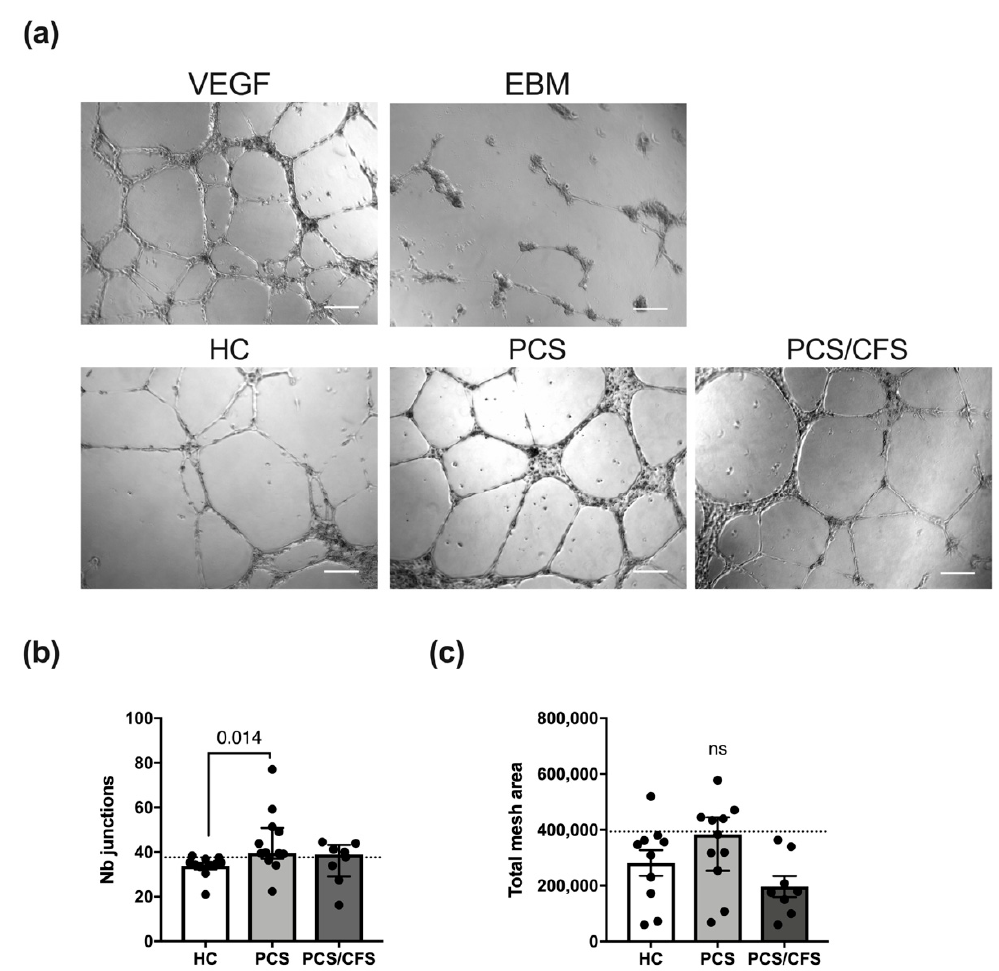
Figure 4. In vitro angiogenesis assay for serum-treated cultured human endothelial cells. ( a ) Representative micrographs of HUVEC treated with serum of healthy controls (HC) and both patient groups (PCS, PCS/CFS) as well as the two control settings are shown. Scale bars represent 200 µm. Experiments were performed in duplicate wells and micrographs of five areas from each well were taken. Measurements were taken with the Angiogenesis Analyzer plugin of ImageJ 1.50i. Bar graphs display the network analysis parameters ( b ) number of junctions and ( c ) total mesh area, across the patient and control groups. Shown are median, interquartile range and individual values Dotted lines denote the 90th percentile of the HC group. Statistical significance was determined using a Kruska-Wallis test. A p value ≤ 0.05 was considered significant. HC, healthy controls (n = 10). PCS, post-COVID-19 syndrome (n = 11). PCS/CFS, post-COVID-19 syndrome with ME/CFS (n = 8). ns, not significant ( p value >